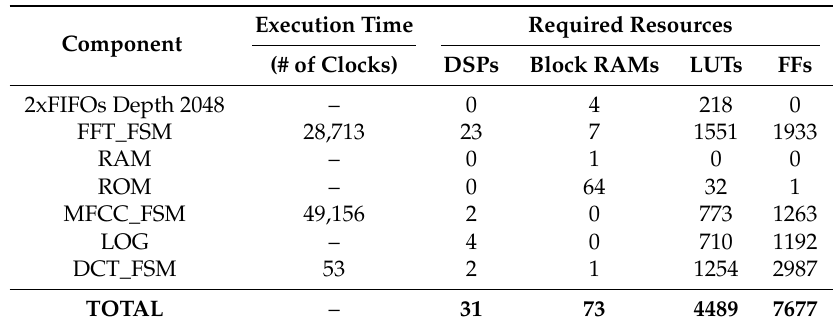
Table 3. Execution time and required resources for the full implementation proposed of the Mel Frequency Cepstral Coefficients (MFCC) algorithm.